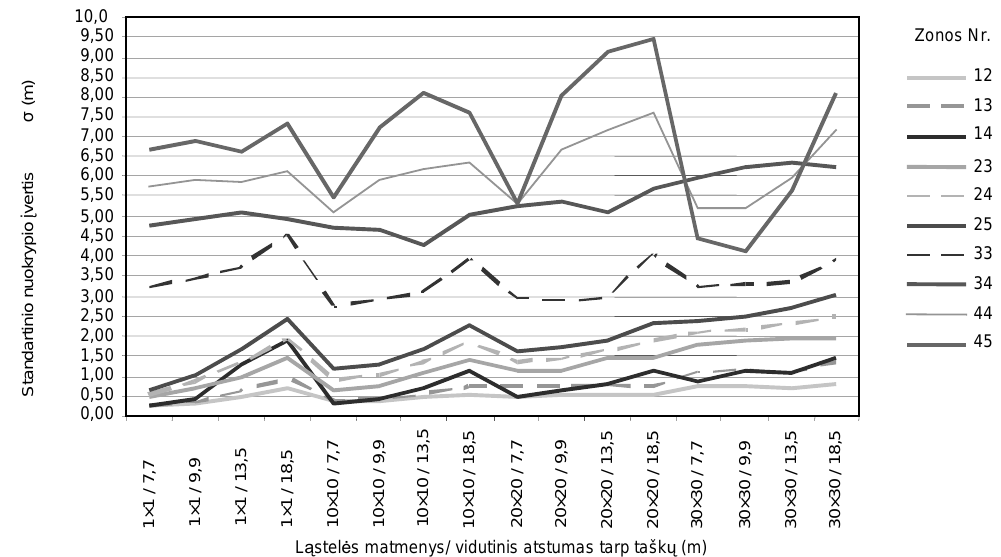
Fig 5. Accuracy analysis of DEM made by IDW